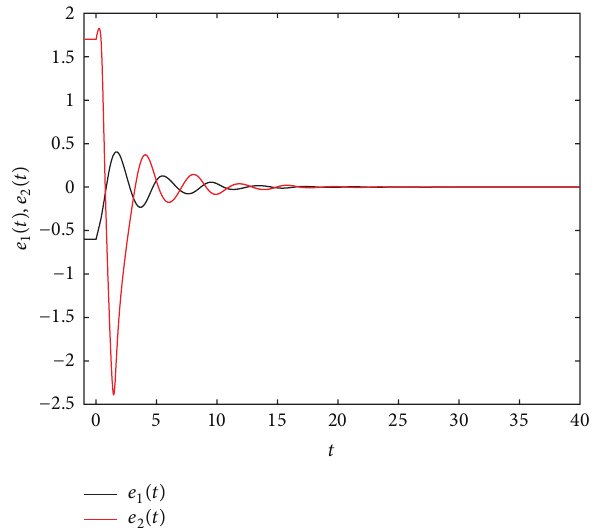
Figure 2: Time response of synchronization error 𝑒(𝑡) = 𝑦(𝑡)−𝑥(𝑡)